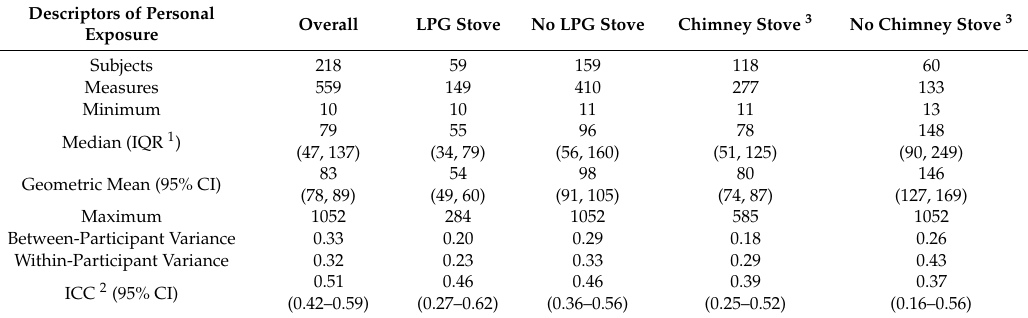
Table 3. Description of the distribution of personal 24-h average PM 2.5 ( µ g / m 3 ) exposure overall, by liquefied petroleum gas (LPG) ownership, and by biomass chimney stove